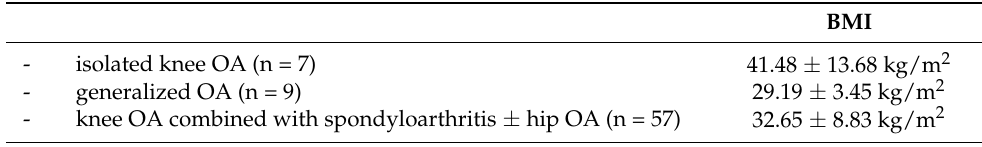
Table 3. BMI in patients with different clinical forms of OA.